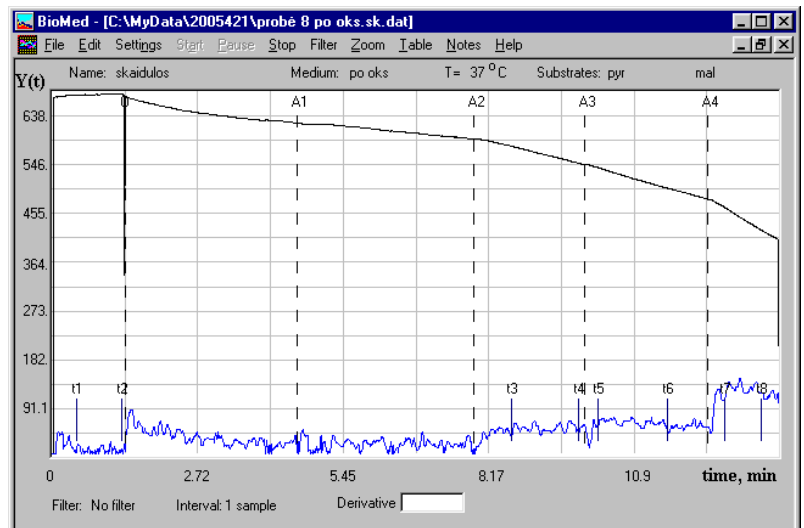
Figure 6. Representative respiration curve after the complete oxidation of a limited quantity of palmitoyl- L -carnitine. The black curve—oxygen consumption, the blue curve—oxygen consumption derivative. Additions: O—skinned rat cardiac fibers (registration of respiration on endogenous substrates), then A1—1.6 nmol of palmitoyl- L -carnitine, A2—pyruvate + malate (6 mM + 6 mM, respiration rate: 24.8 nmol/O/min/mg dry weight), A3—10 µM ADP (respiration rate: 32 nmol / O / min / mg